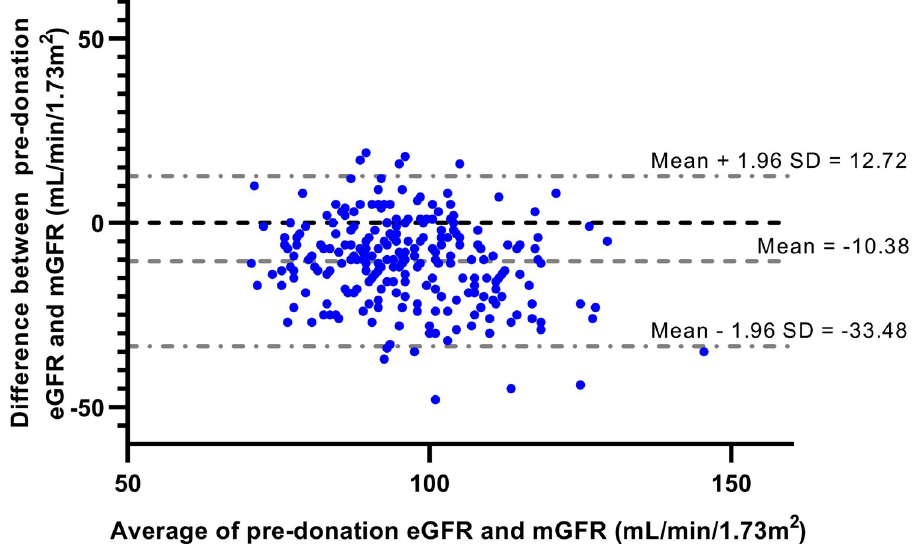
Fig 1. Bland-altman plot of pre-donation eGFR and pre-donation mGFR. Bias between pre-donation eGFR and pre-donation mGFR is shown on the X-axis, the average between pre-donation eGFR and pre-donation mGFR is shown on the Y-axis. Mean ± SD bias was -10.38 mL/min/1.73m 2 , the 95% confidence interval of the mean bias was -33.48 to 12.72 mL/min/1.73m 2